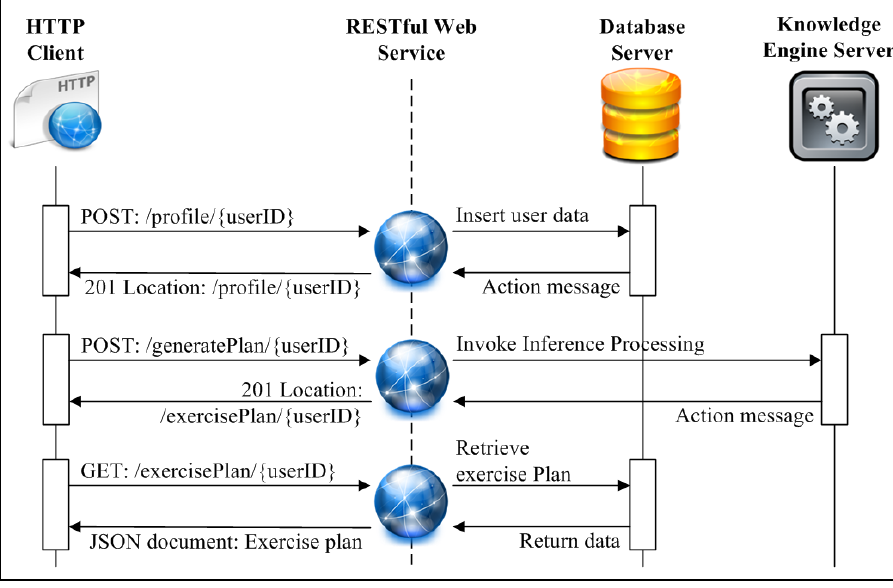
Figure 10. The usage example of REST Service.